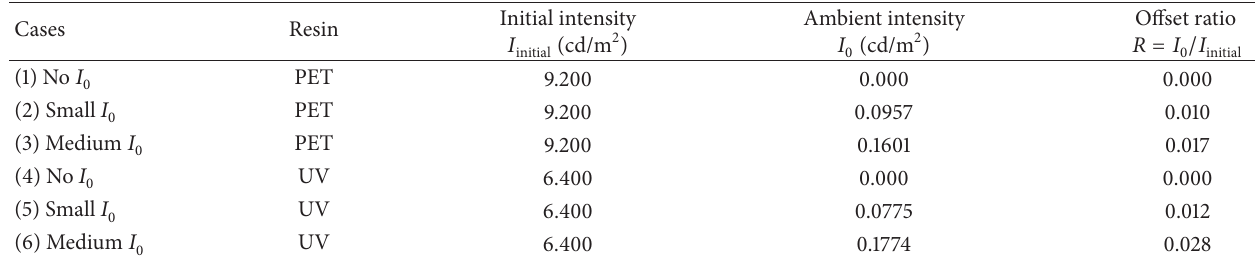
Table 1: The test